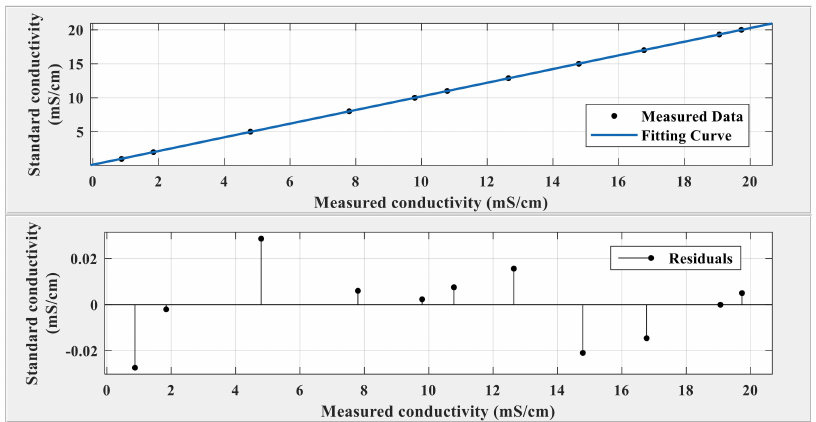
Figure 16. Fitting curve and residual error after